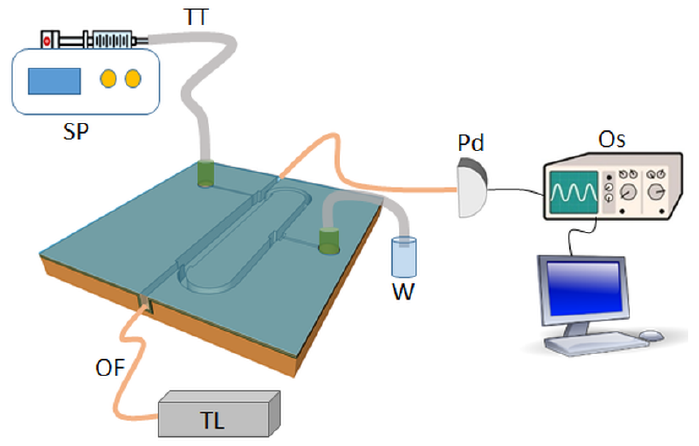
Figure 11. Schematic of the experimental setup. TT, Tygon tubing; SP, syringe pump; OF, optical fiber; Pd, photodiode; TL, tunable laser; W, waste.